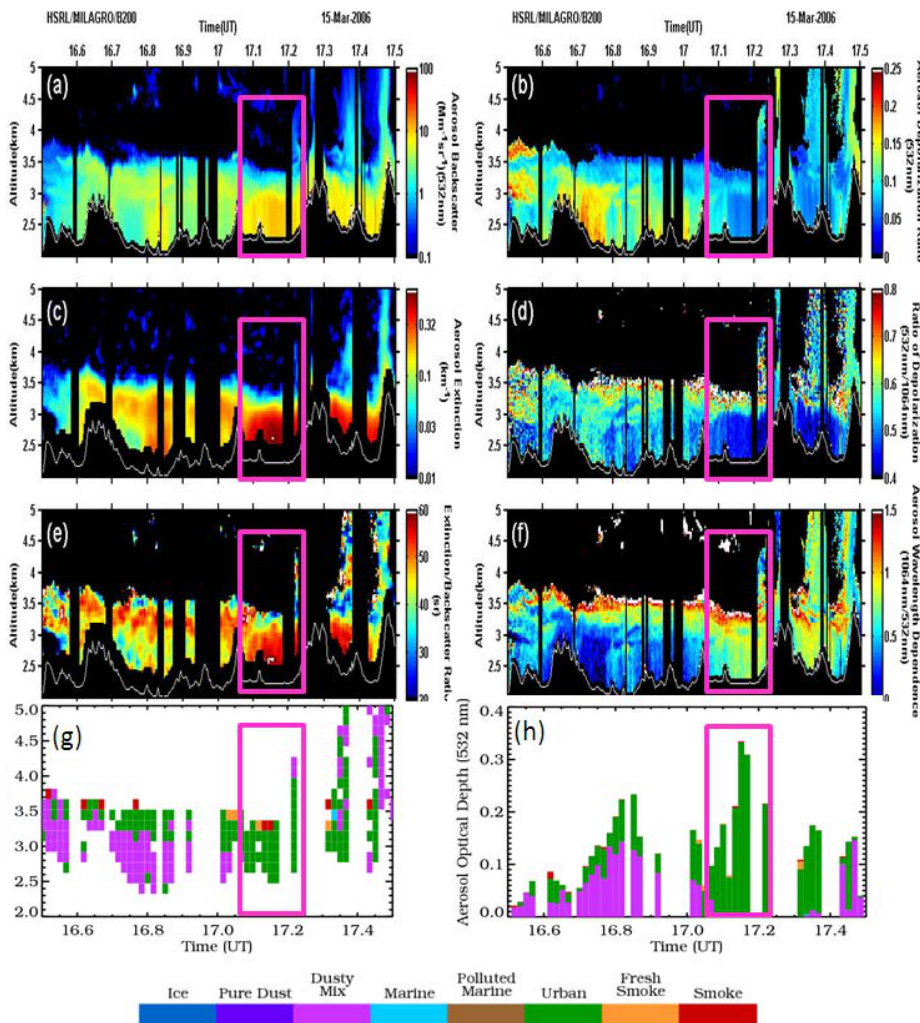
Fig. 13. Suite of airborne HSRL aerosol measurements acquired on 15 March 2006 in the Mexico City region. (a) aerosol backscatter (532nm), (b) aerosol depolarization (532nm), (c) aerosol extinction (532nm), (d) ratio of aerosol depolarization (532/1064nm), (e) aerosol extinction/backscatter ratio, (f) backscatter wavelength dependence (1064/532nm), (g) aerosol type inferred from the HSRL measurements, and (h) aerosol optical thickness (532nm) contributed by each aerosol type. In (h), the total length of the bar represents the total aerosol optical thickness. The color bar at the bottom denotes the various aerosol types. The purple box between 17:05–17:25UT indicates when the King Air flew directly over the city from northwest to southeast. Prior to that time, the King Air flew to the north and east of the Mexico City region. Over the city, the HSRL measurements indicate that urban (polluted) aerosols had the greatest contribution to AOD; in contrast, outside the city, a mixture of dust and urban aerosols had the greatest contribution to